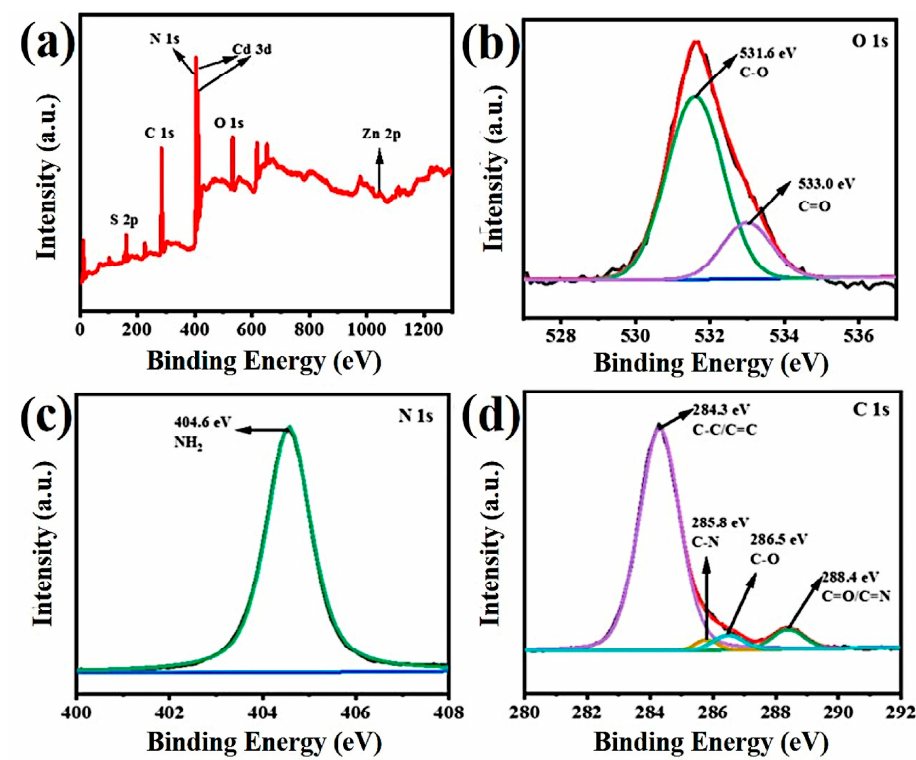
Figure 3. ( a ) Full scan XPS spectrum of the Zn 0.2 Cd 0.8 S@CD composite; high-resolution XPS O 1s; ( b ) N 1s; ( c ) C 1s; ( d ) spectrum of Zn 0.2 Cd 0.8 S@CDs.